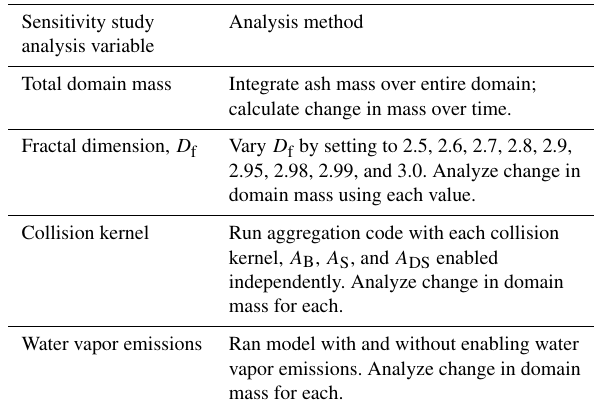
Table 4. Details of the model sensitivity studies discussed, includ- ing parameters varied and the analysis methodology.